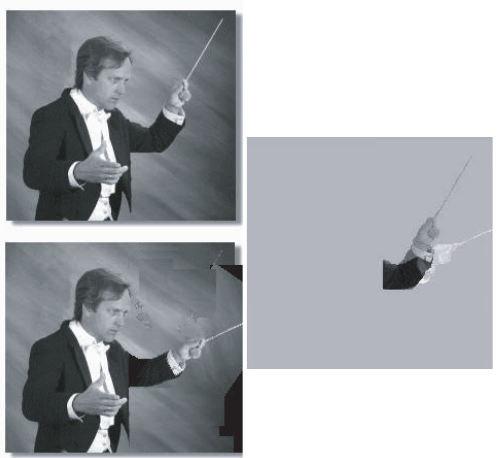
Figure 3: (left) Two frames in a video of a conductor. (Right) The result of a pixel by pixel subtraction of the two images. Subtracting one frame from the other in a video shows only what has moved, and thus gives essential information about the nature of the gesture, and to the action that the game is to perform as a result. (Dr.